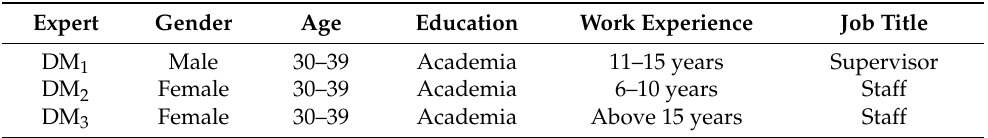
Table 5. Basic information on the three experts.